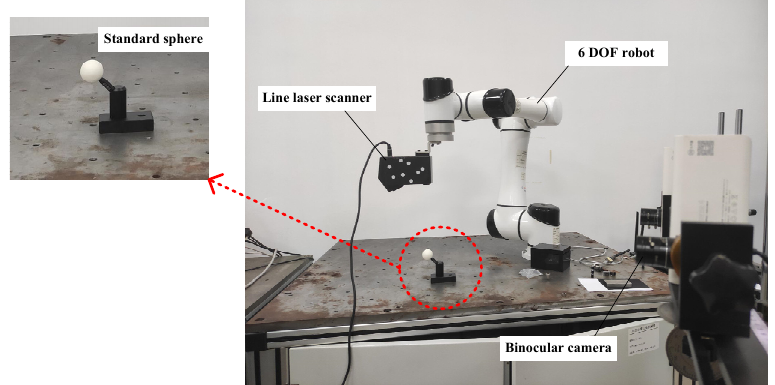
Figure 8. Physical diagram of system configuration.